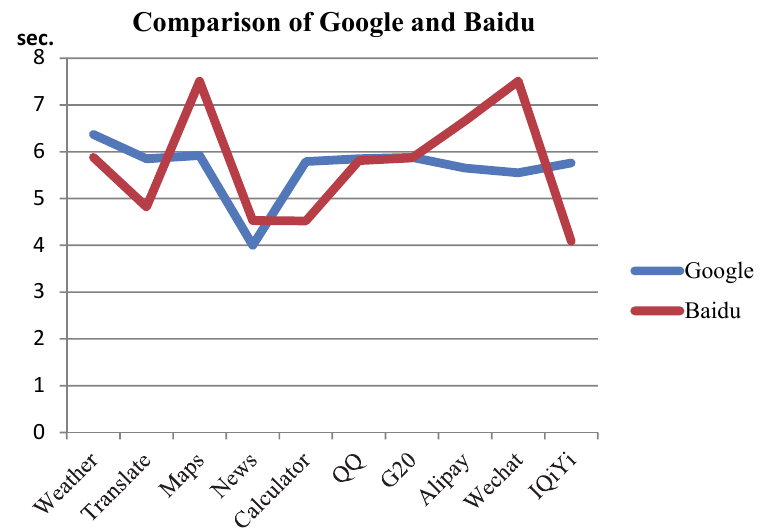
Fig. 3. Comparison of Search completion time in Google and Baidu